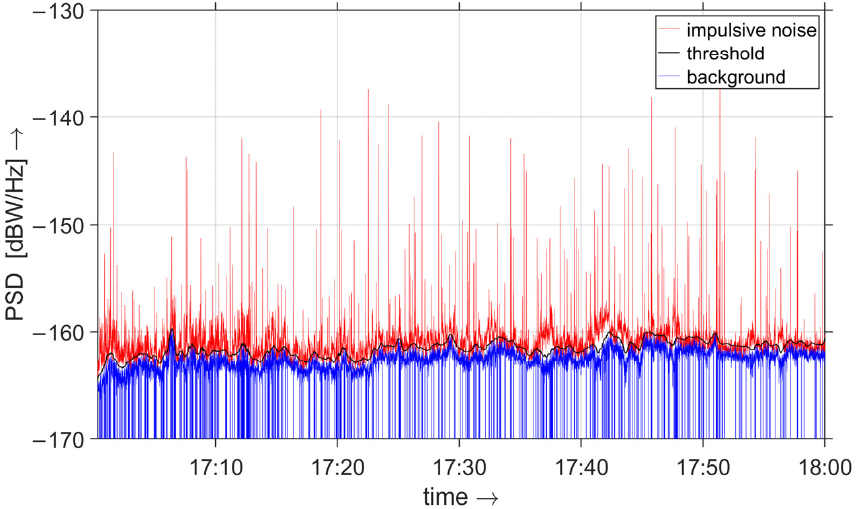
Figure 10. Time segment showing 1 h of measurements before (red) and after (blue) impulsive noise blanking. The dynamic threshold is shown in black.